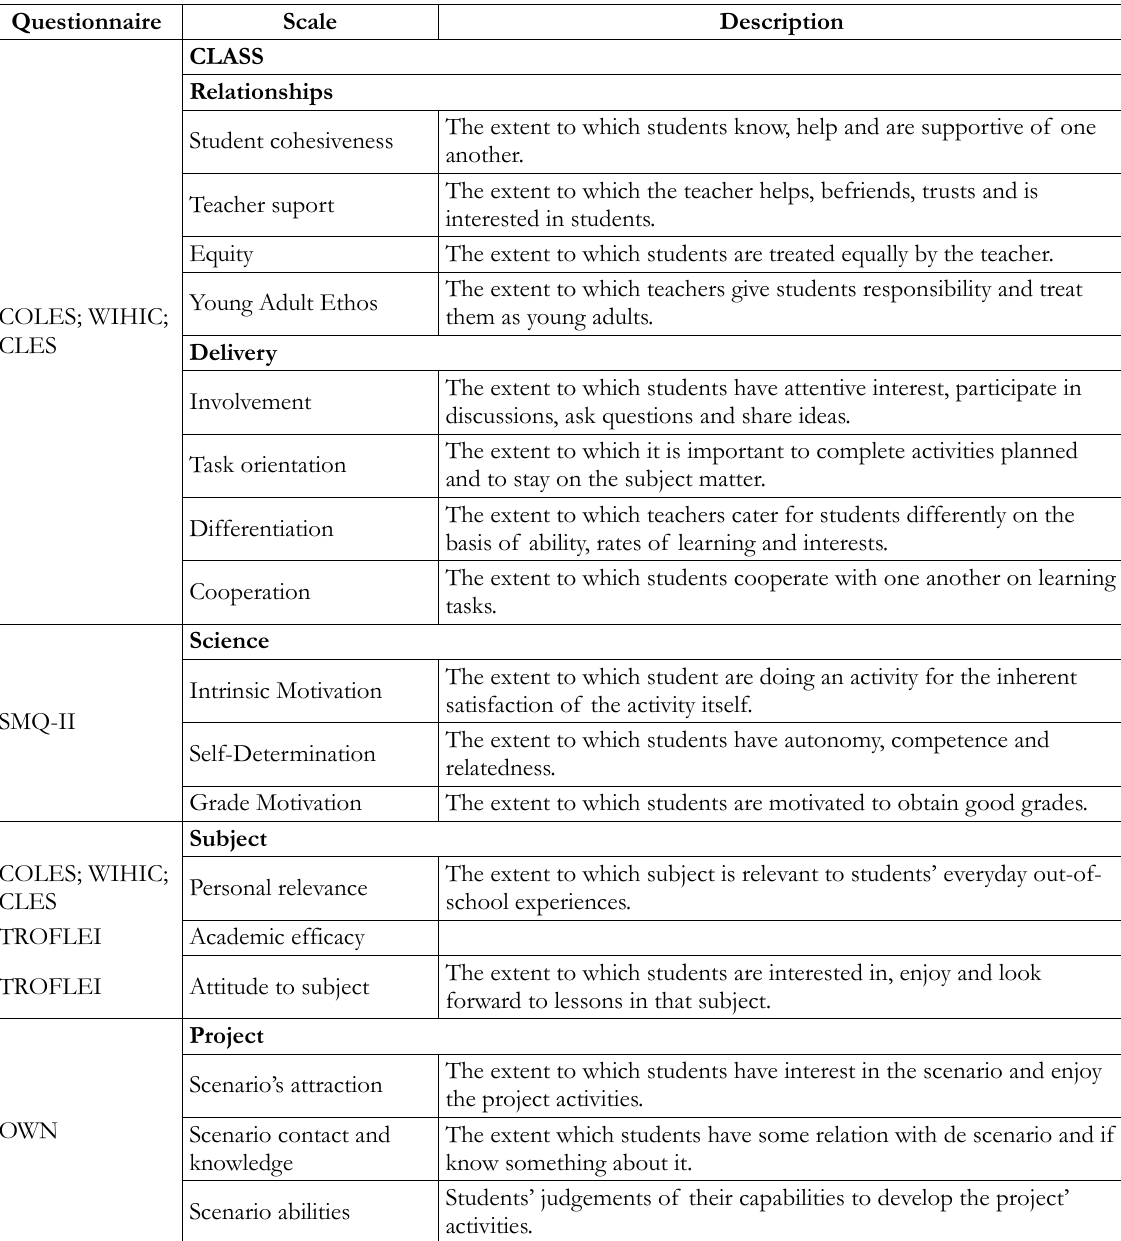
Table 3. Description of the 17 areas in the student